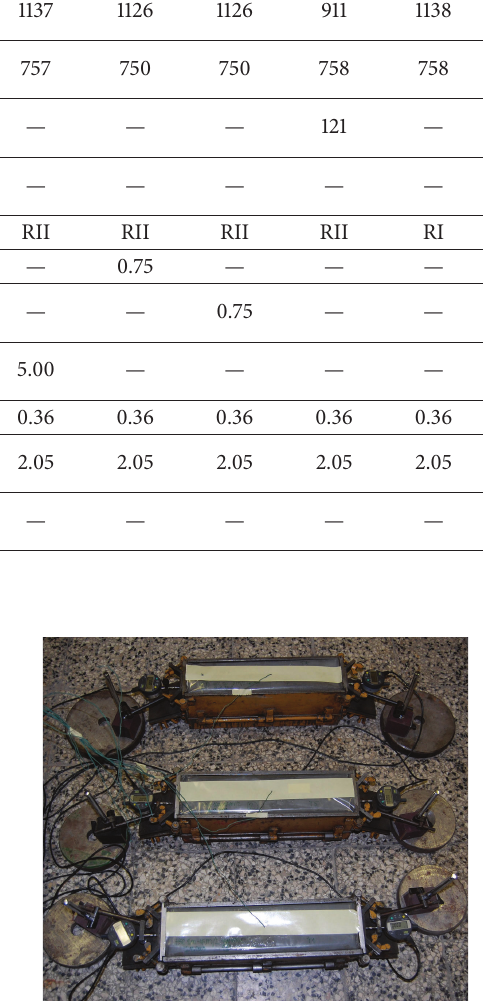
Figure 4: Measurement of the autogenous shrinkage of a test